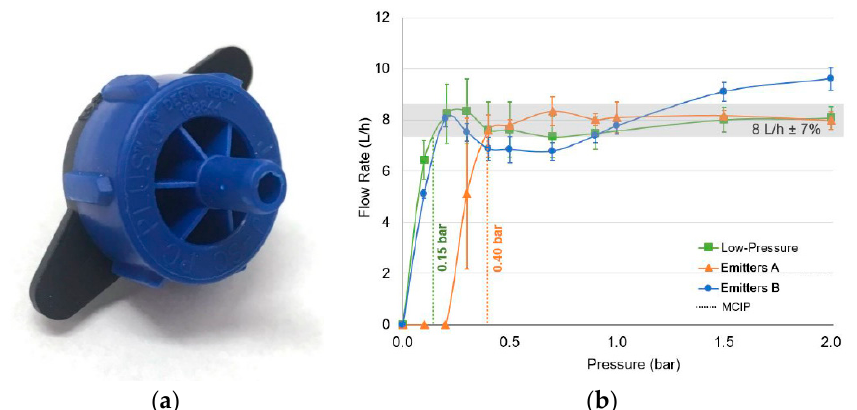
Figure 3. ( a ) Photograph of the low-pressure emitter. ( b ) Characteristic curves for low-pressure and conventional emitters used in field trials, as measured in lab tests ( n = 25 for each type of emitter; mean and standard deviation are plotted). All emitters have a nominal flow rate of 8 L/h, low-pressure emitters have an MCIP of 15 ± 5 kPa (0.15 ± 0.05 bar); emitters A (conventional on Morocco sites) have an MCIP of 40 ± 5 kPa (0.40 ± 0.05 bar) for the PC-NL version; emitters B (conventional on Jordan sites) have an undefined MCIP as the flow does not reach a compensated state, but the minimum pressure above which the flow rate remains equal to or greater than nominal is 95 ± 5 kPa (0.95 ± 0.05 bar).